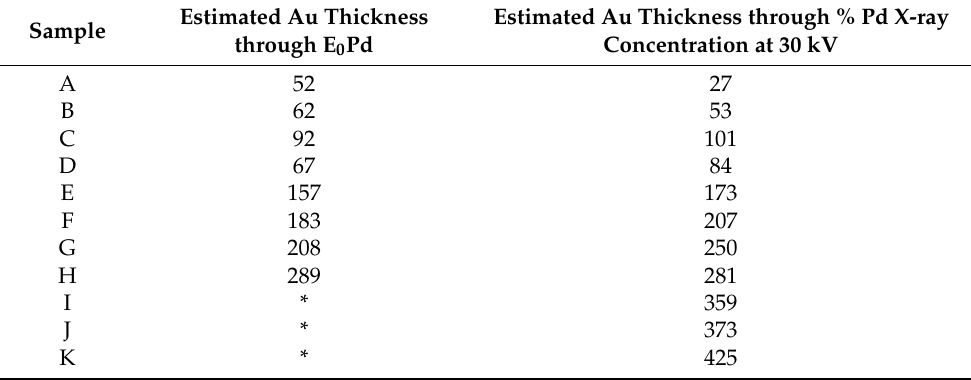
Table 7. Comparison of estimated Au thickness for samples A–K obtained by E 0 Pd signals and % Pd X-ray concentration at 30 kV.